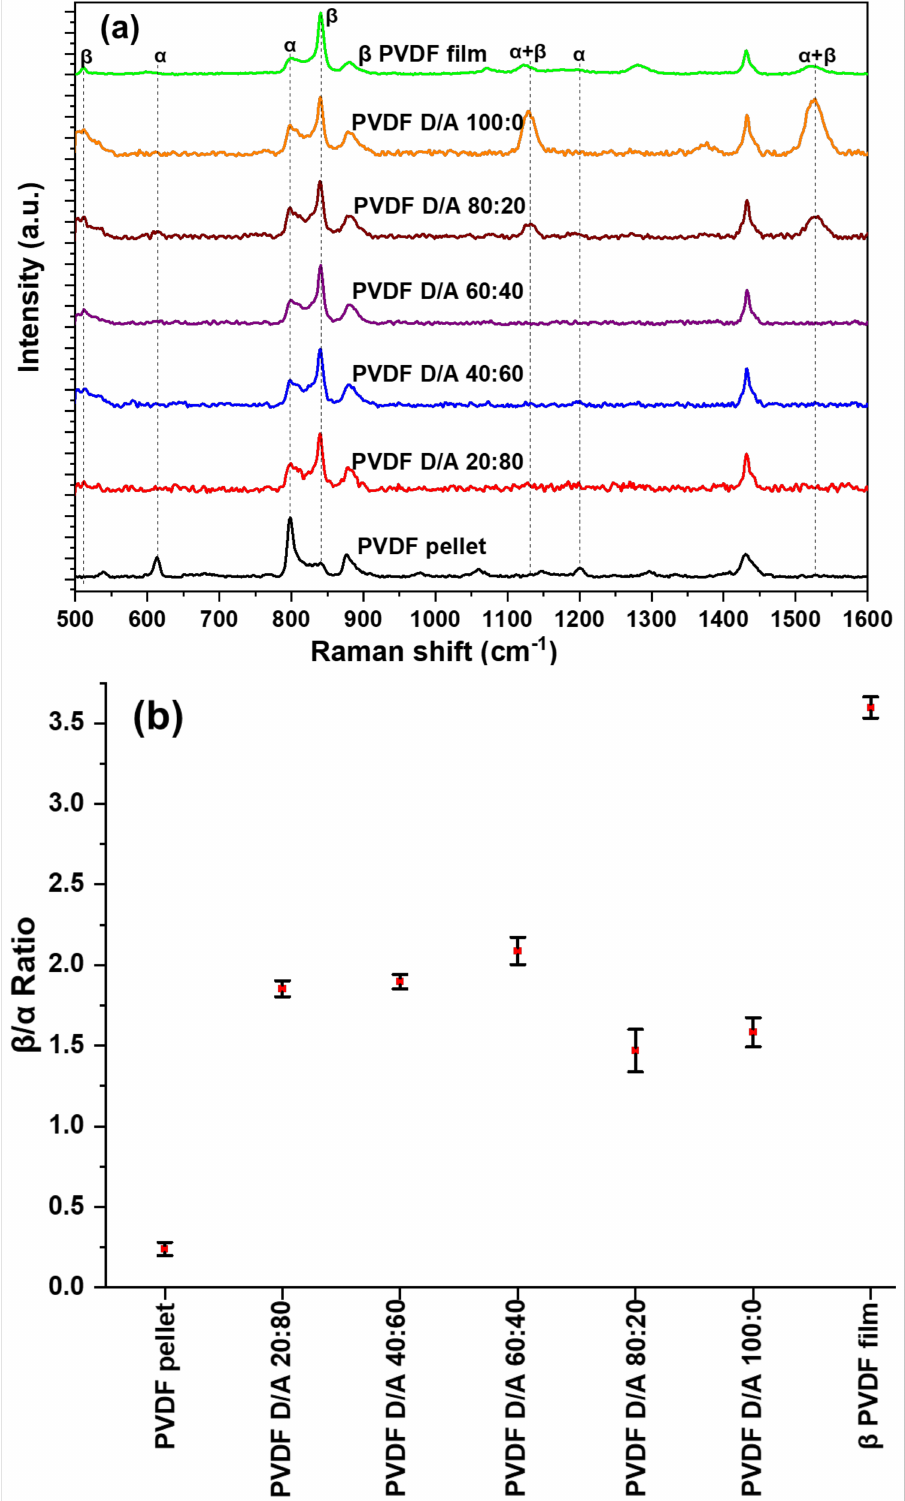
Figure 4. ( a ). Raman spectrums of electrosprayed microparticles, PVDF pellet, and β -phase PVDF film ( b ) Average beta to alpha ratios of